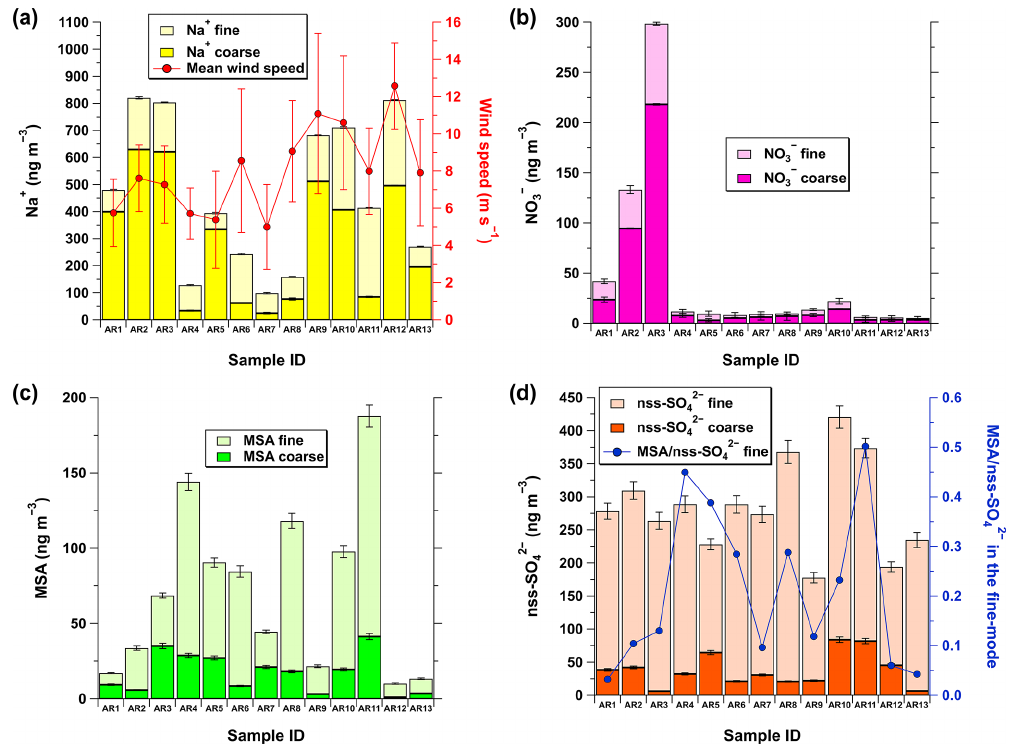
− (ngm − 3 ), (c) MSA (ngm − 3 ), and (d) nss-SO 2 − (ngm − 3 ) in aerosols collected Figure 2. Concentrations of (a) Na + (ngm − 3 ), (b) NO 3 4 from the coastal (AR1–AR3) and sea-ice-covered areas (AR4–AR13) of the western Arctic Ocean during the summer of 2016. The solid red line with circles and error bars in (a) indicates the mean and standard deviation of wind speeds for each aerosol-sampling time. The solid blue line with circles in (d) represents the MSA-to-nss-SO42 ratio in the fine-mode